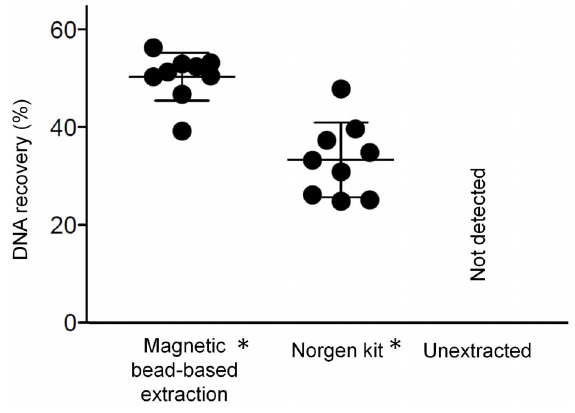
Figure 2. The DNA recovery for the magnetic bead-based extraction method and a commercially available laboratory- based kit are comparable. Though both are significantly higher than the unextracted sample, which is undetectable by PCR, there is no statistical difference between the two extraction methods (mean 6 s.d., n=9); * denotes statistically higher recovery than unextracted